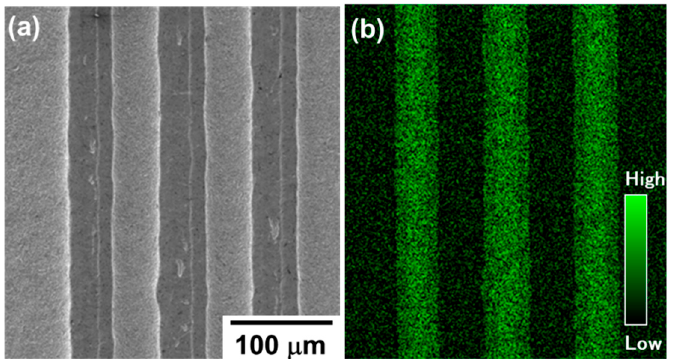
Figure 11. SEM image and nitrogen mapping on the micro-punch heads with three continuous closed loops. ( a ) SEM image and ( b ) nitrogen mapping.